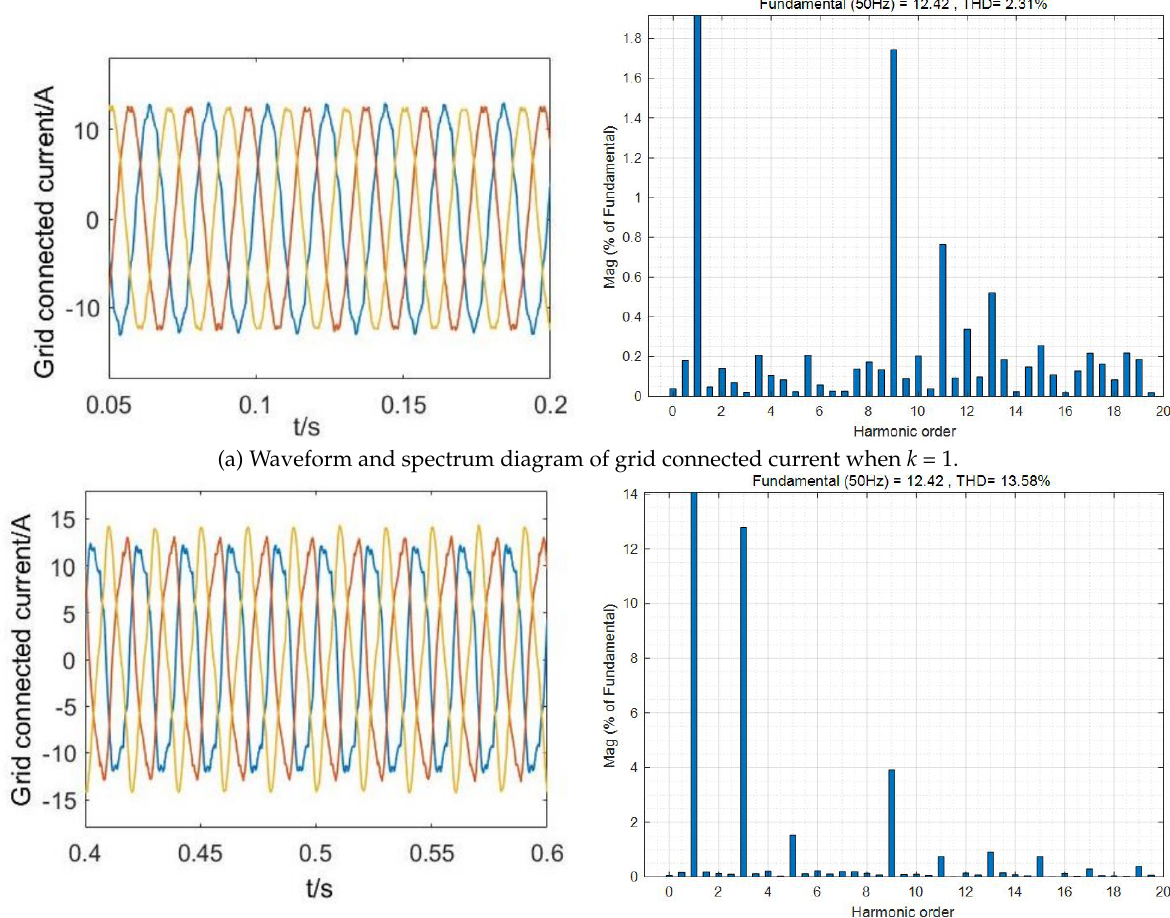
Fig. 12. Waveform and spectrum of grid connected current at k = 1 and k =